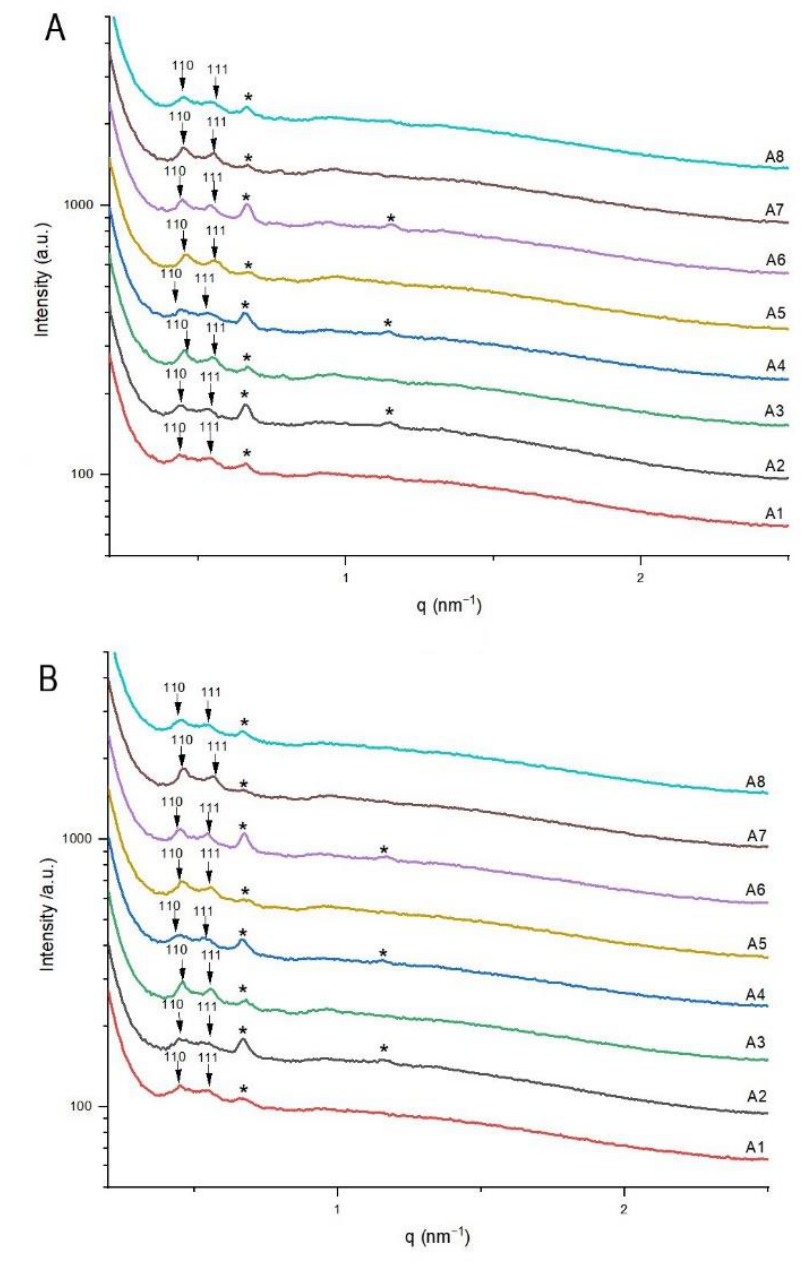
Figure 4. Structural features of continuously produced TQ-free and TQ-loaded citrem/SPC nanodis- persions (samples A1–A8, Table 1) using microfluidics. SAXS patterns at 25 ( A ) and 37 °C ( B ). The detected Bragg peaks and corresponding Miller indices for the inverse bicontinuous cubic Pn3m are presented and marked with arrows. In panels A and B, the detected two characteristic peaks for the coexisting swollen L α phase are marked with black asterisks. All nanodispersions were produced at citrem/SPC weight ratio of 2:3 and constant ethanol and lipid (SPC plus citrem) concentrations of 2.86 and 1.9 wt%,